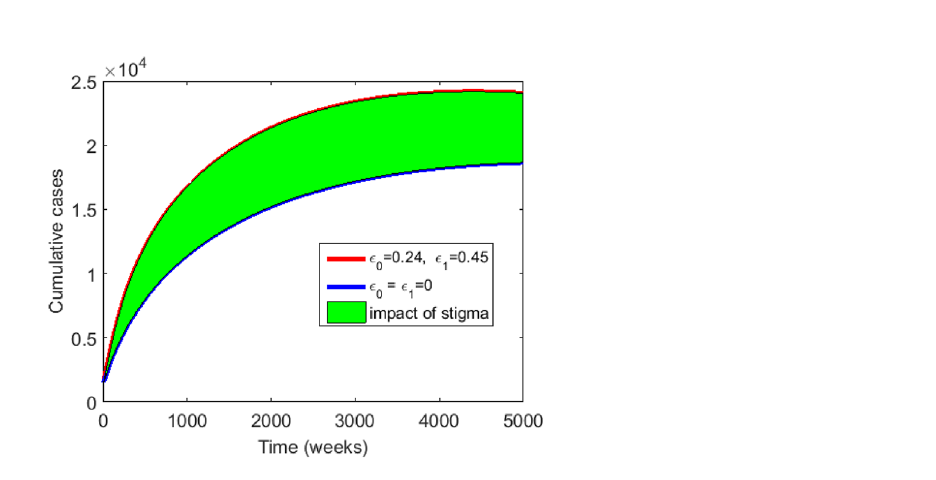
Figure 8. Graph of cumulative EVD cases without stigma in blue and with stigma in